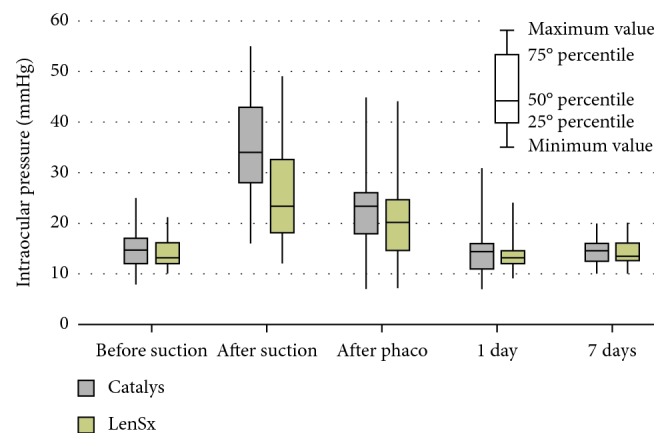
Intraocular pressure values measured at different time points during FLACS performed with two different devices: Catalys and LenSx. The box is determined by the central mean as well as the 25th and 75th percentiles. The whiskers represent the minimum value (0th percentile) and the maximum value (100th percentile).